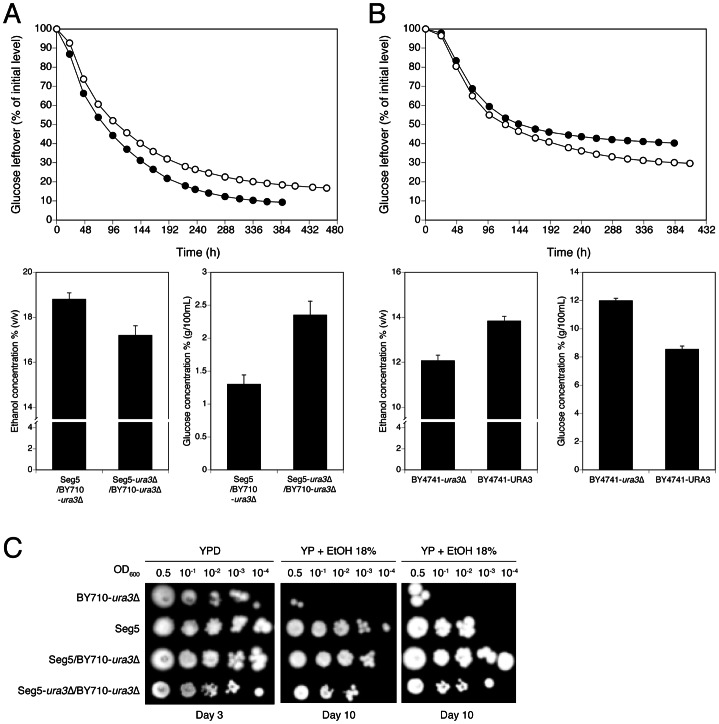
Loss of function assessment and complementation assay with the causative gene URA3 in QTL3.(A) URA3 loss-of-function assay. The strain Seg5/BY710 (•) had its URA3 copy deleted, Seg5-ura3Δ/BY710 (○). Both strains were tested in 250 mL of YP+33% glucose at 25°C. (B) URA3 complementation study. The URA3 auxotrophic strain BY4741-ura3Δ (▪) had the URA3 gene inserted in its original position, BY4741-URA3 (□). The performance of both strains were assessed by semi-static fermentations in 250 mL of YP+33% glucose at 25°C. (C) Determination of ethanol tolerance of cell proliferation with the hybrid diploid strains Seg5/BY710-ura3Δ, Seg5-ura3Δ/BY710-ura3Δ.